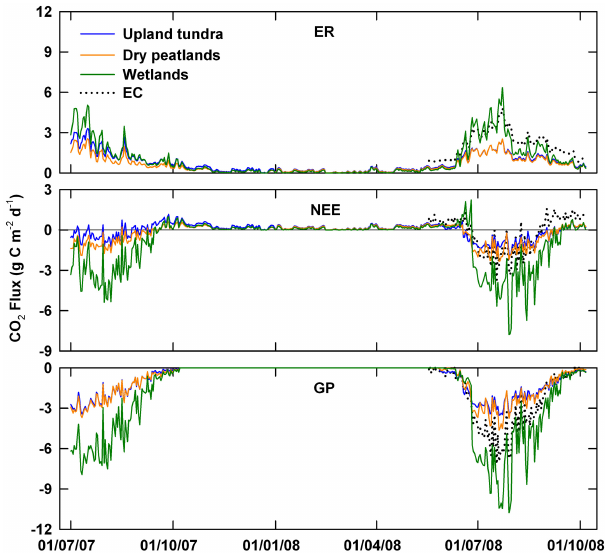
Fig. 4. Seasonal dynamics of CO 2 fluxes of the three main land- scape types (upland tundra, dry peatlands and wetlands) based on chamber measurements and integrated landscape-scale CO 2 flux from eddy covariance. Data are daily mean